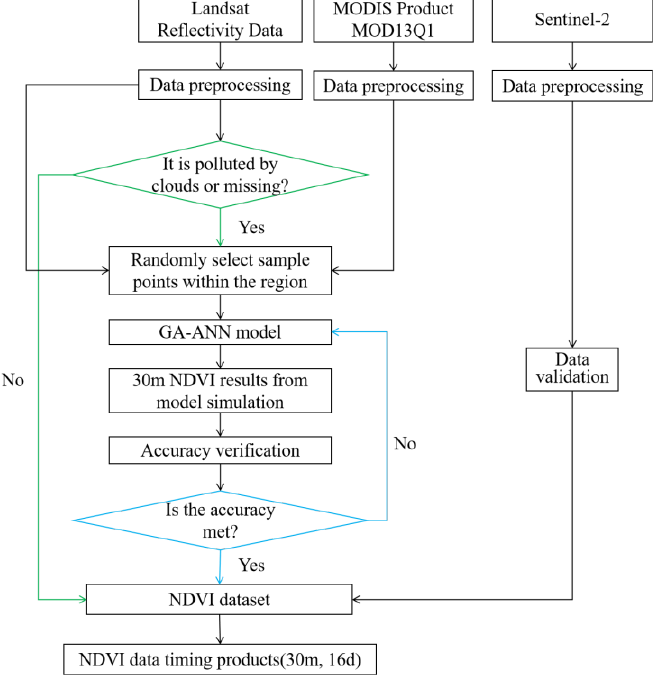
Figure 2. Flowchart for reconstructing the NDVI (“polluted by clouds” refers to areas covered by clouds and cloud shadows; “missing” refers to areas not covered by Landsat imagery). Table 3. Parameters of reconstructed NDVI model based on